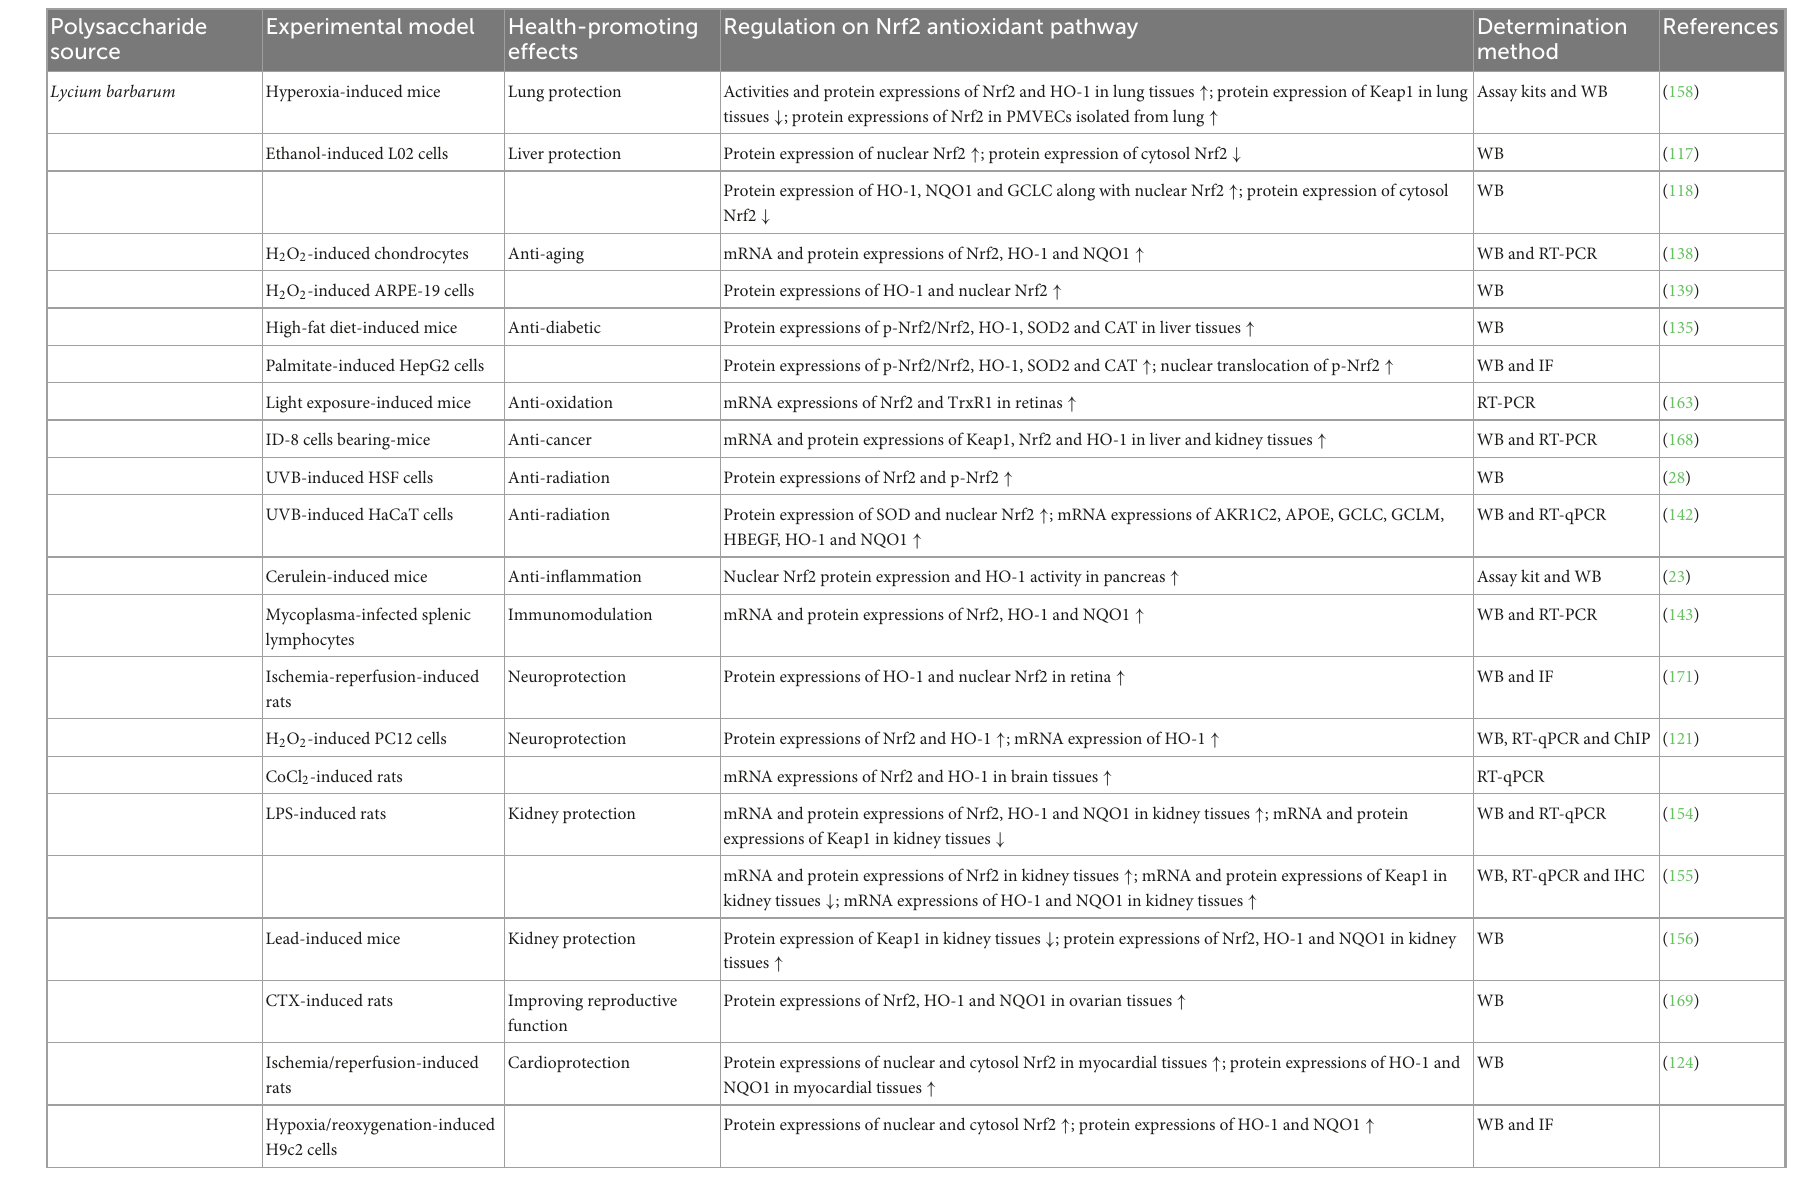
TABLE 1 Regulation of NPs from herbs on Nrf2 antioxidant pathway for health-promoting effects. Polysaccharide